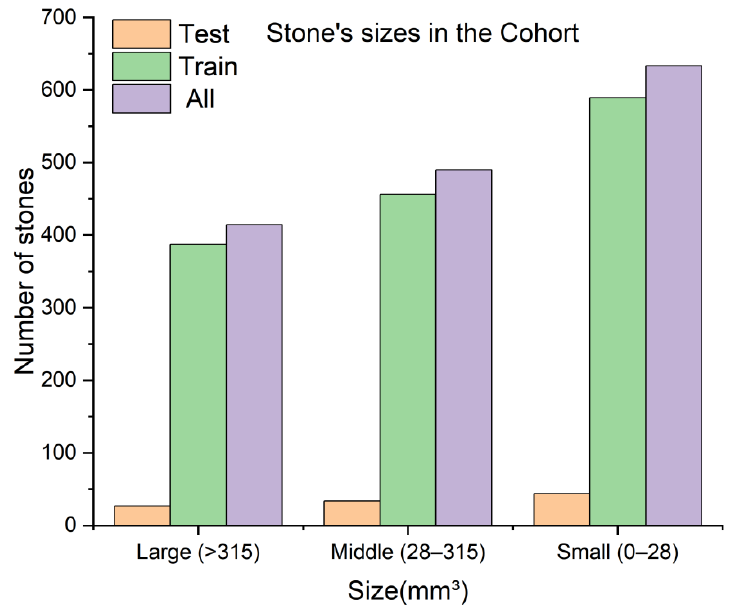
Figure 2. The number of kidney stones and their sizes in the training and test sets.